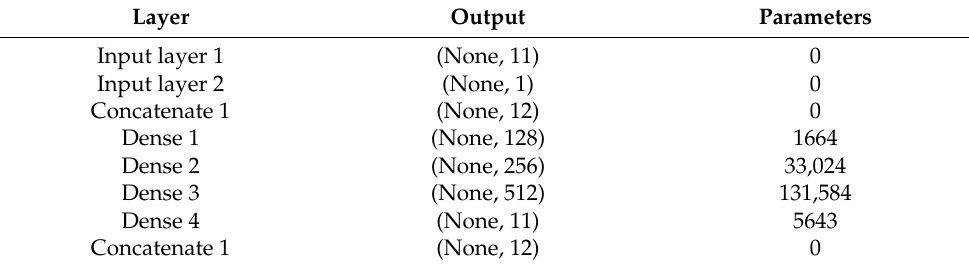
Table 4. CGAN and WCGAN models generator network.